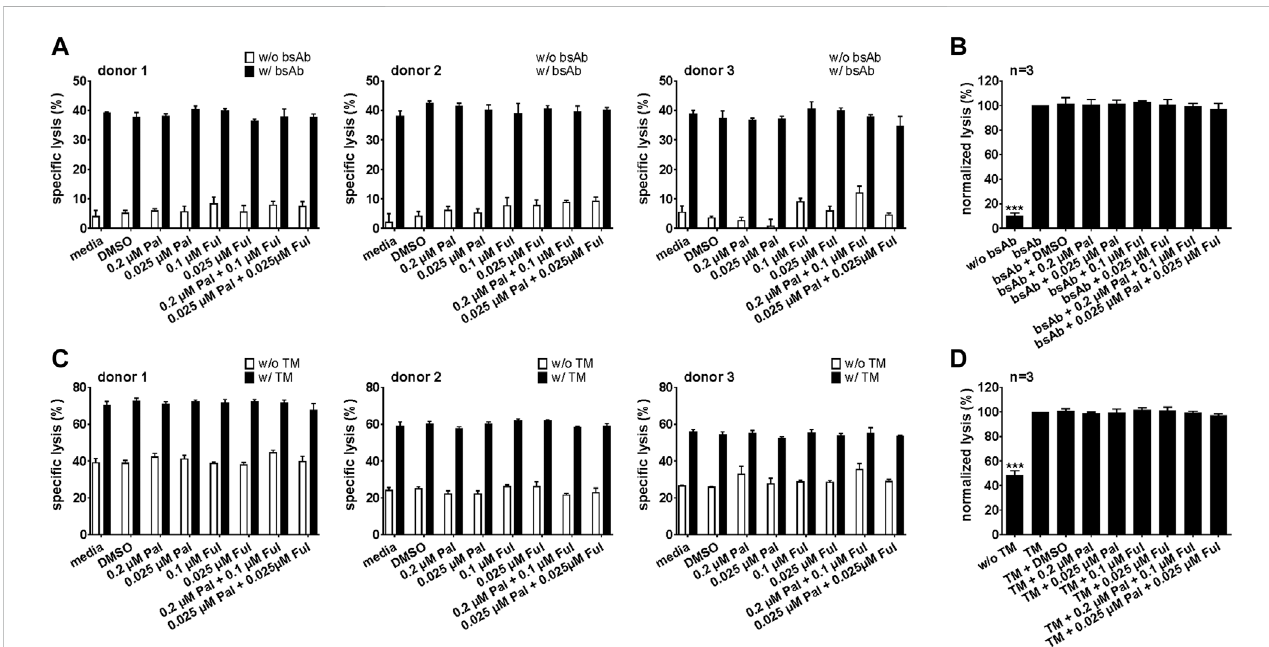
FIGURE 9 Cytotoxic capacity of palbociclib- and fulvestrant-pretreated bsAb-engaged T cells and UniCAR T cells. After pre-incubation of (A,B) T cells or (C,D) UniCAR Tcells without orwith palbociclib and/orfulvestrantfor 24 h,luciferase-basedkillingassays wereperformed.Therefore,preincubated (A,B) Tcells or (C,D) preincubated UniCAR T cells were cultured with PC3-PSCA/PSMA Luc+ cells in the presence or absence of 30 nM (A,B) CD3-PSCA bsAb or (C,D) PSCA TM. After 8 h, speci fi c lysis was determined. (A,C) Each diagram shows mean speci fi c lysis ± SEM of triplicates for one T cell donor. (B,D)